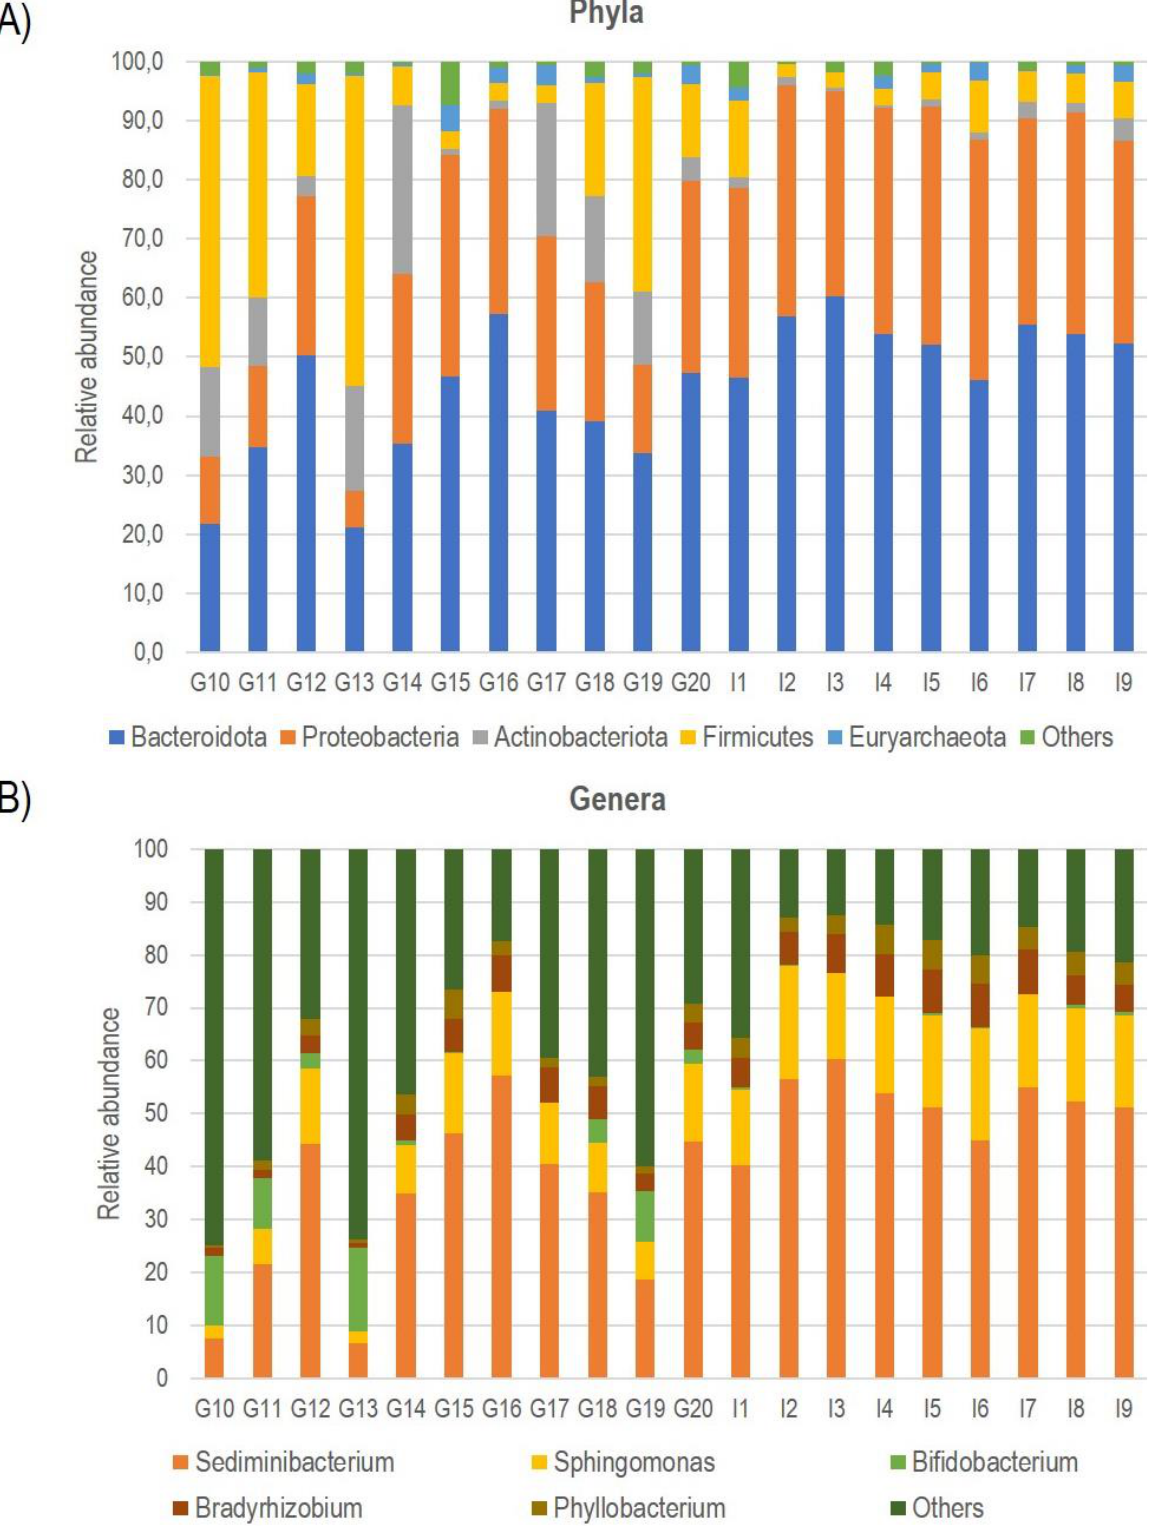
FIGURE 1: Bar plot showing the relative abundance of the five most represented Phyla (A) and Genera (B) documented in all CAV